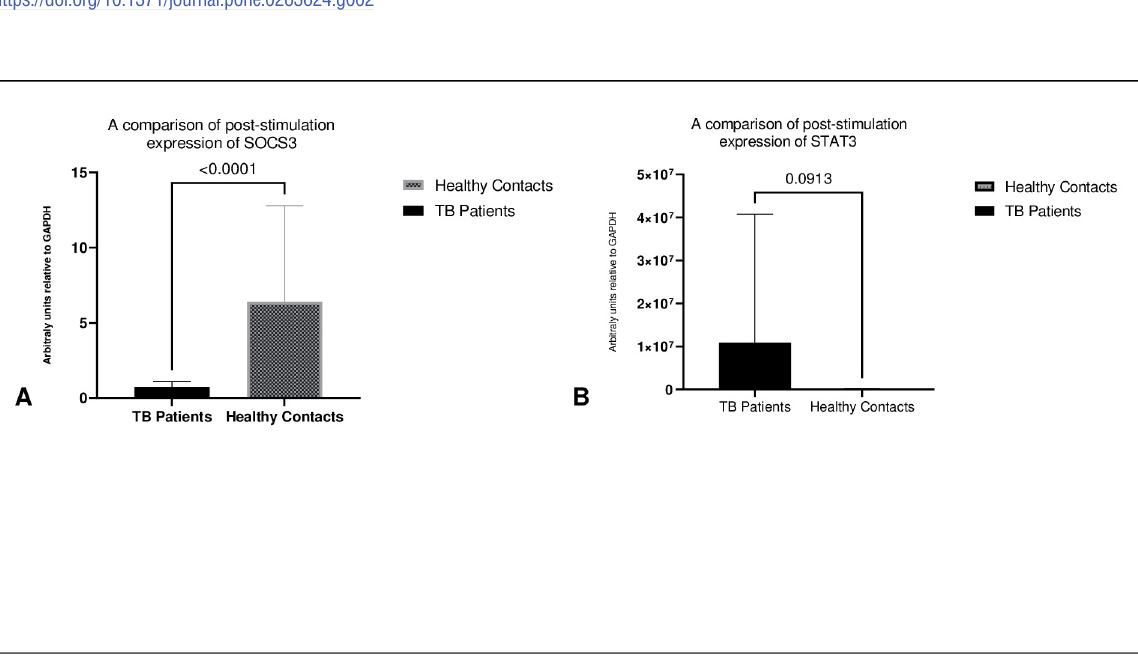
PLOS ONE | https://doi.org/10.1371/journal.pone.0263624 July 15,